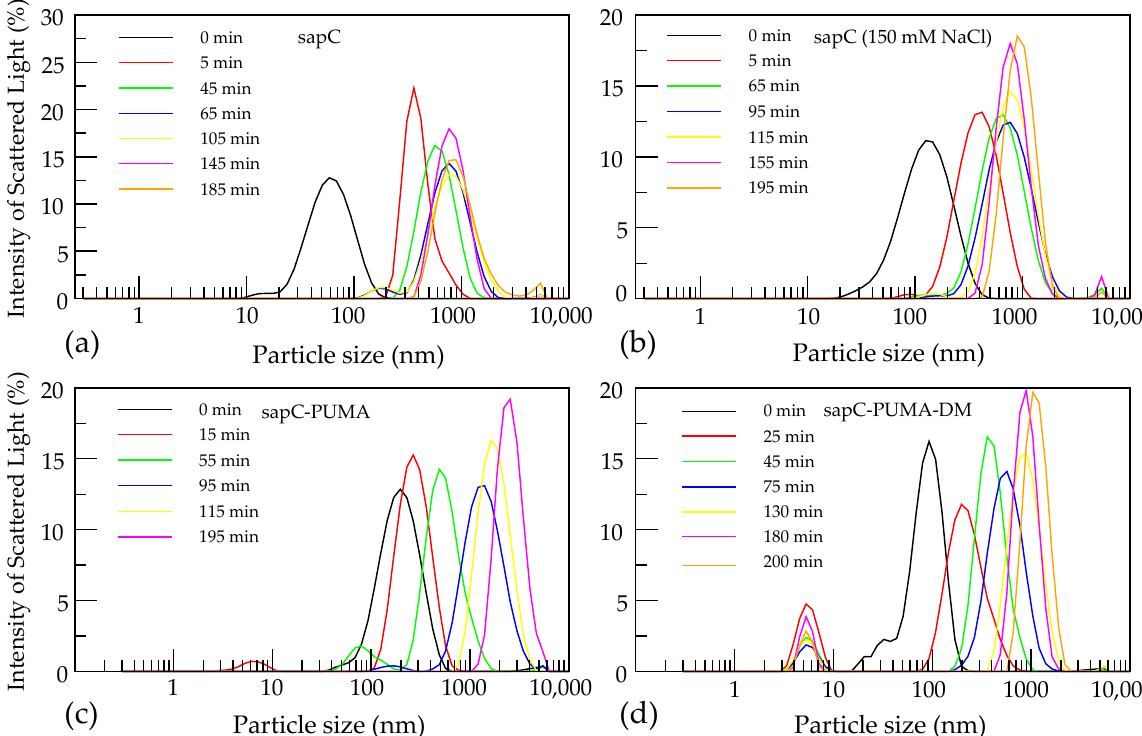
Figure 9. Liposome fusion mediated by sapC, sapC-PUMA, and sapC-PUMA-DM: Analysis of the intensity of the scattered light reveals an increase in liposome diameter (“0 min” indicates liposome size before protein addition) in a time-dependent manner after the addition of ( a ) sapC in water ( b ) sapC in the presence of 150 mM NaCl; ( c ) sapC-PUMA; ( d ) sapC-PUMA-DM. Signals appearing below 10 nm correspond to unbound protein.